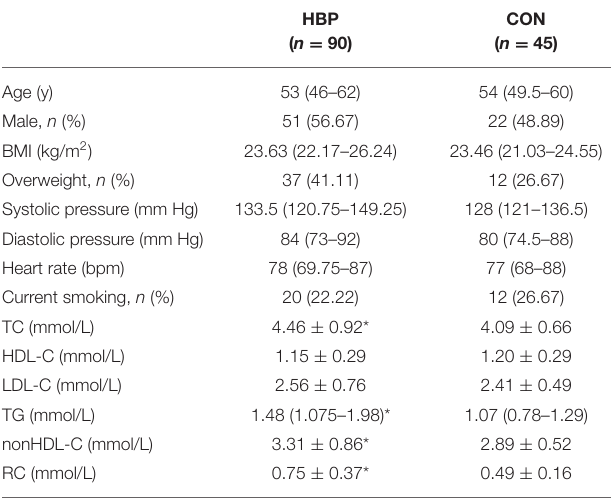
TABLE 1 | Comparison of clinical characteristics and fasting blood lipids of the two